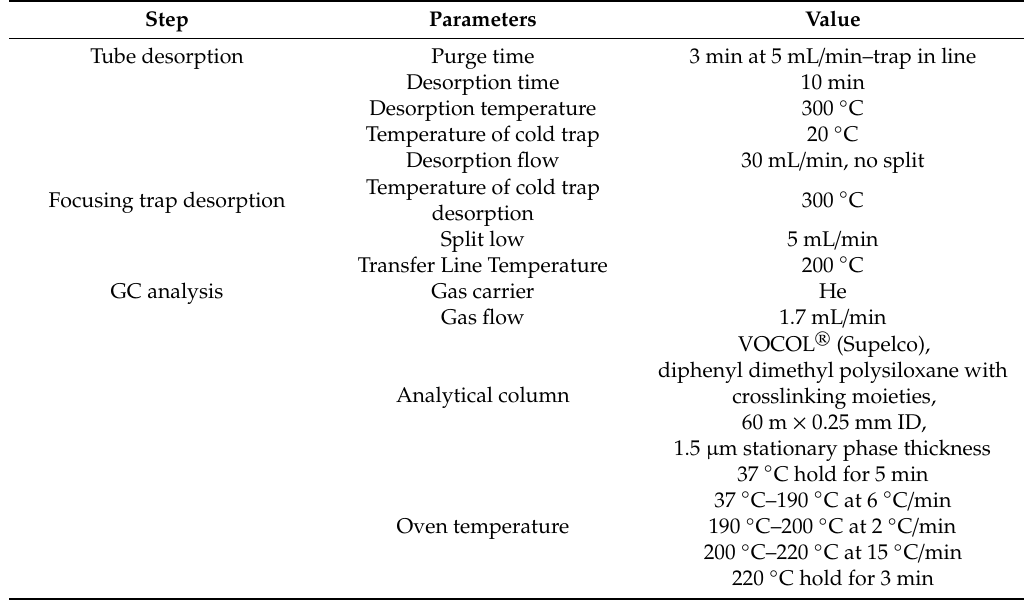
Table 1. Operative condition of TD-GC / MS